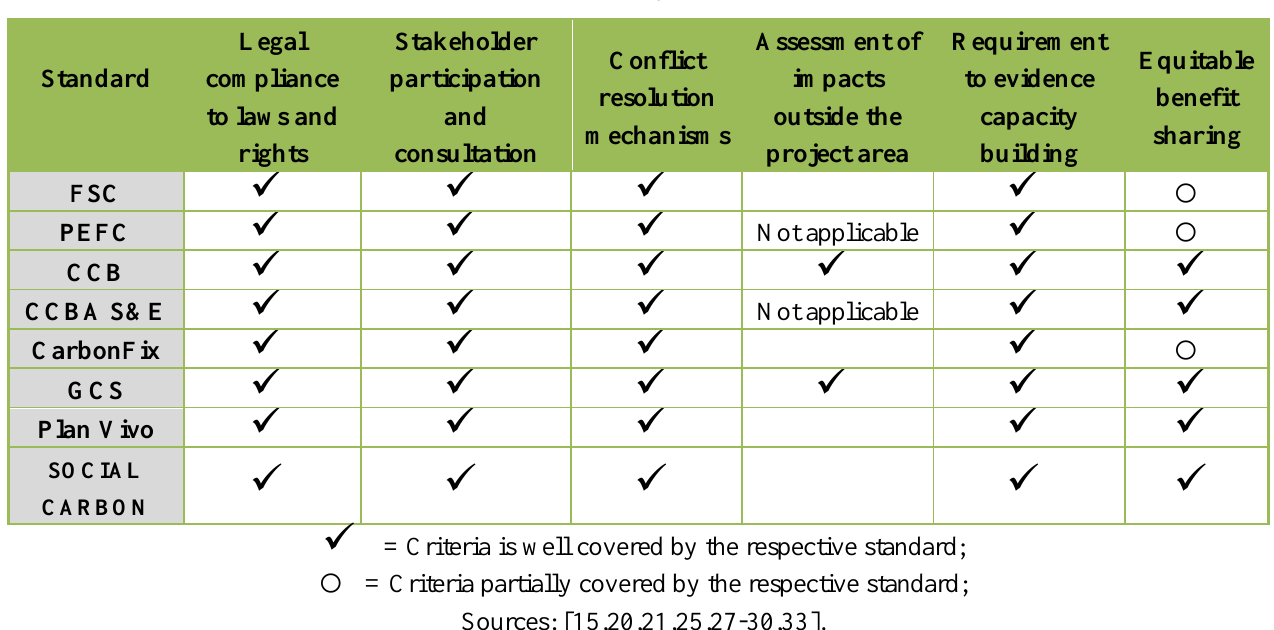
Table 2. Standards’ poverty alleviation approaches.